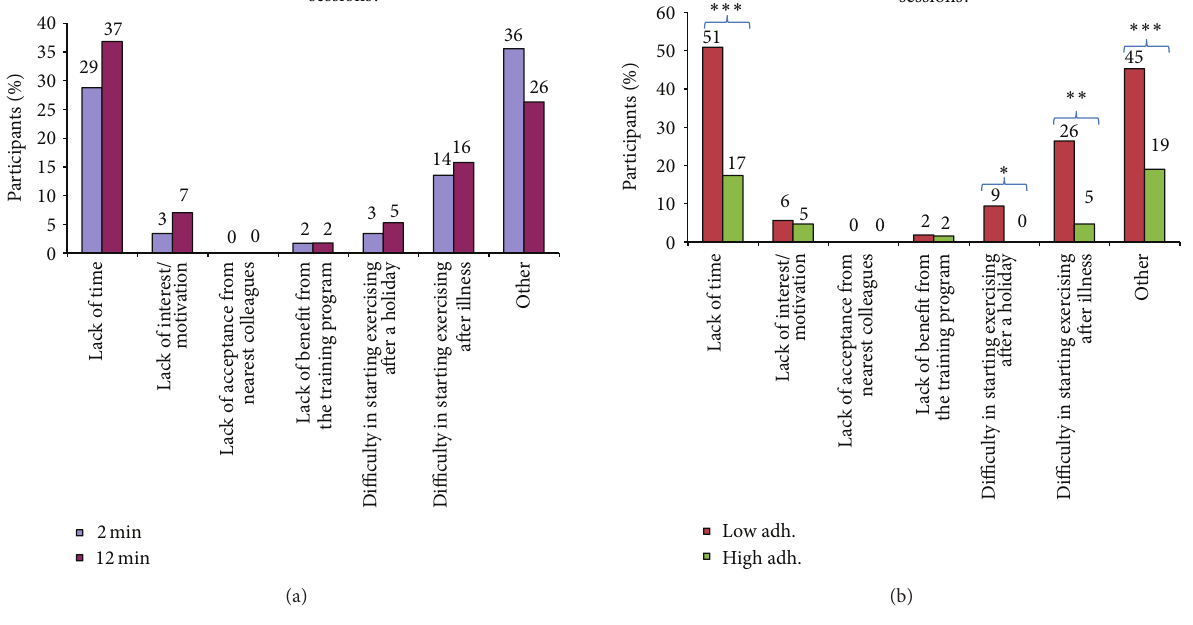
Figure 5: (a) Follow-up questionnaire (satisfaction, barriers, and facilitators). Reasons for missing exercise sessions in the 2 and 12 min groups (multiple-choice question). (b) Follow-up questionnaire (satisfaction, barriers, and facilitators). Reasons for missing exercise sessions among those with low and high adherence (multiple-choice question). ∗, ∗∗, ∗∗∗ Significant difference (Fisher’s exact test, 𝑃 < 0.05 , 0.01, 0.001,